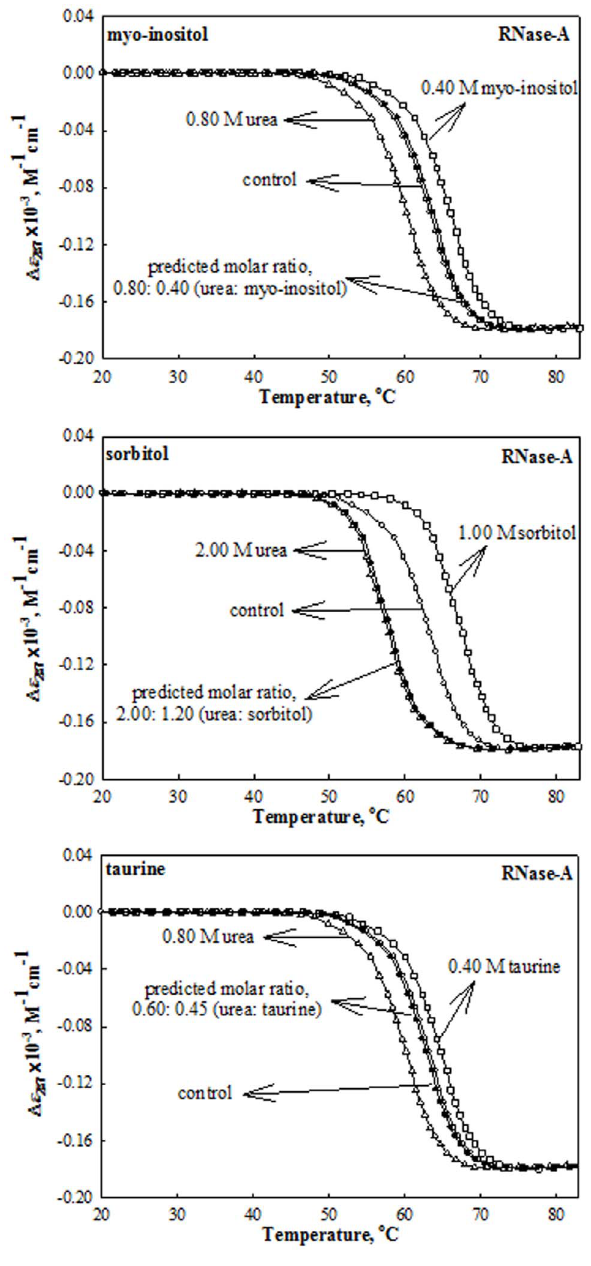
Figure 1. Effect of urea, stabilizing osmolytes and their mixtures (at predicted ratio for perfect counteraction) on RNase-A at pH 7.0 and 25 6 C. Representative thermal denaturation curves of RNase-A in the presence of the indicated concentrations of urea, osmolytes and their mixtures at predicted ratios given in Table 2. To maintain clarity all data points and all transition curves are not shown.